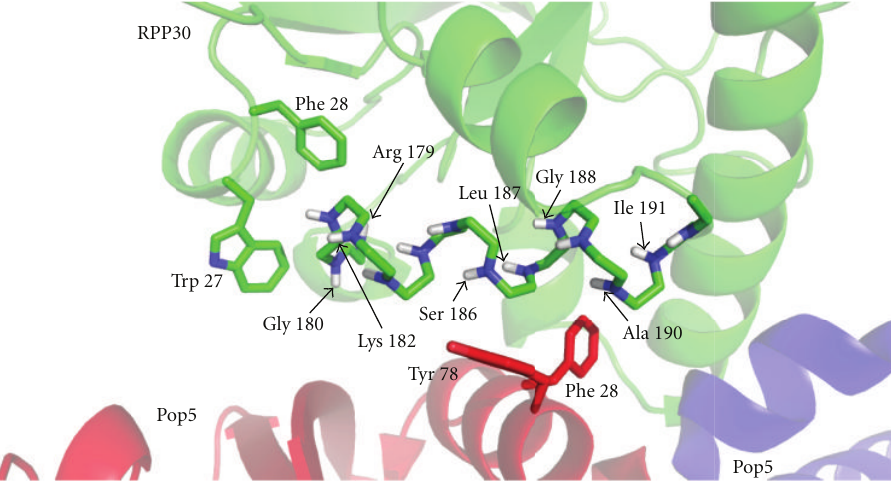
Figure 8: Close-up view of the Pop5-RPP30 binding interface. RPP30 is green and the two Pop5 subunits are red and blue. The backbone of α 8 in RPP30 is shown as sticks with the amide nitrogen and proton atoms shown in blue and white, respectively. The sidechains of aromatic residues from Pop5 and RPP30 near α 8 in RPP30 are shown as sticks. Electronic ring currents from such aromatic residues can result in large chemical shift perturbations for amides in the protein-protein